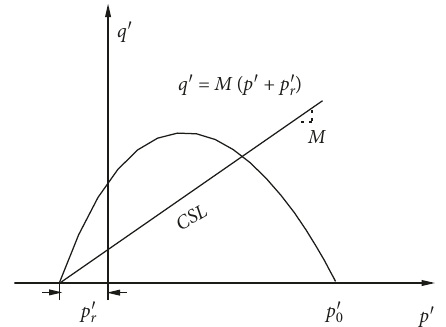
Figure 2: The yield curve of the modified Cam-clay model de- veloped by [29].